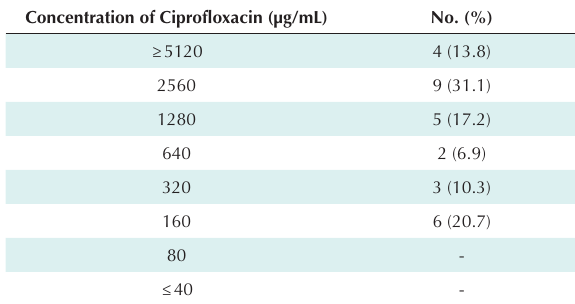
Table 1. Frequency and Percentage of Isolates Based on Qualitative MBEC in Various Concentrations of